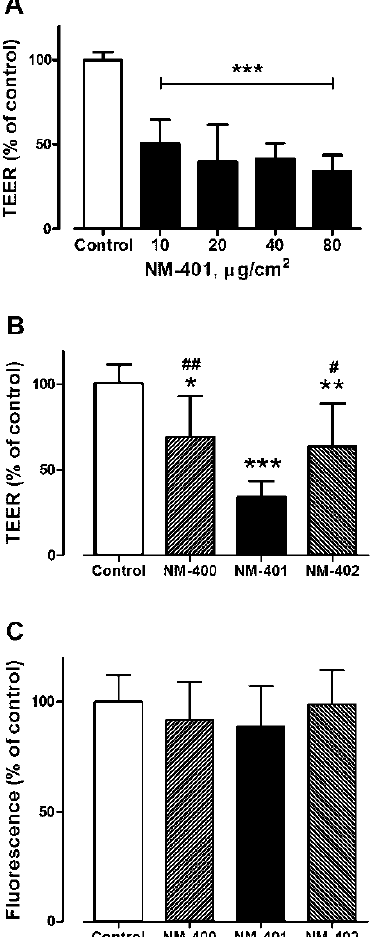
Figure 6. E ff ects of NM-400, NM-401, and NM-402 on the trans-epithelial electrical resistance (TEER) and viability of Calu-3 monolayers. Calu-3 cells were cultured for 10 days on 0.4-mm membrane filters. At the end of this period, MWCNT were added to the apical chamber of the culture system, at the doses indicated ( A ) or at 80 µ g / cm 2 ( B , C ). TEER (A,B) and viability (C) were determined after 12 days. Data are the means ± SD ( n = 4). *, **, and *** p < 0.05, 0.01, and 0.001 vs. control, untreated cultures; # and ## p < 0.05 and 0.01 vs. monolayers treated with NM-401.